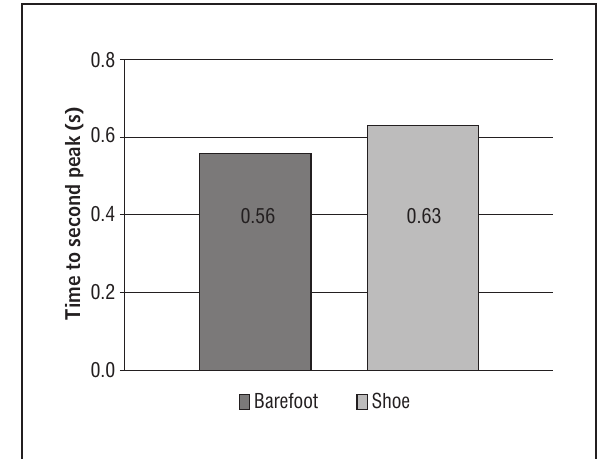
Figure 5 - Time of second peak force for barefoot and foot- wear use